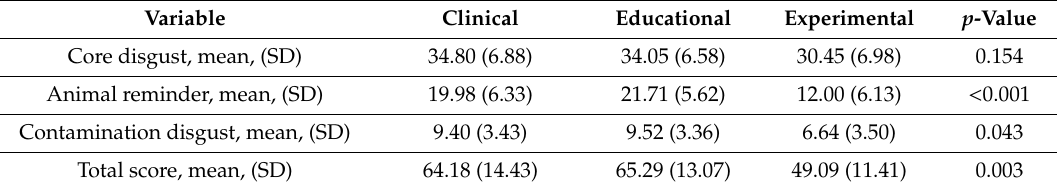
Table 3. Score distribution in relation to postgraduate orientation of psychology students.